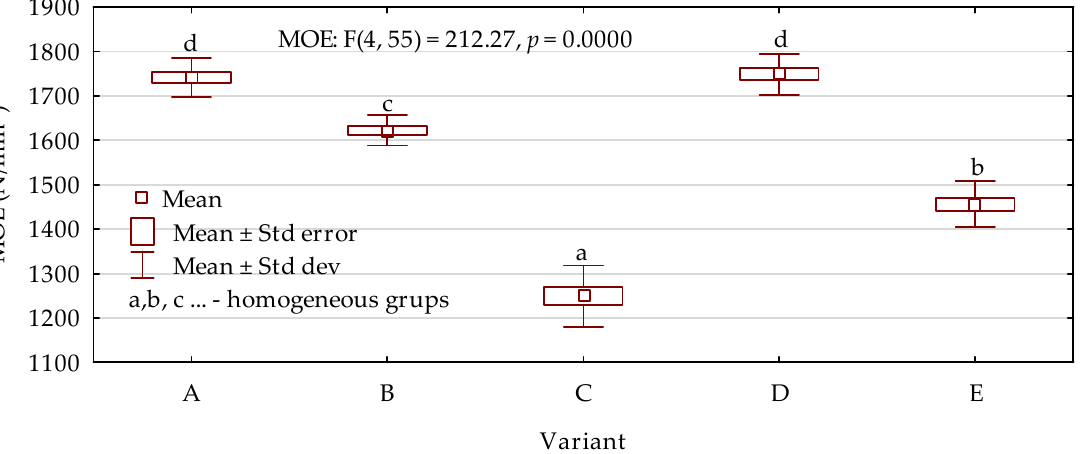
Figure 5. Modulus of elasticity results depending on the board variant (letters A–E mark variants of the boards).